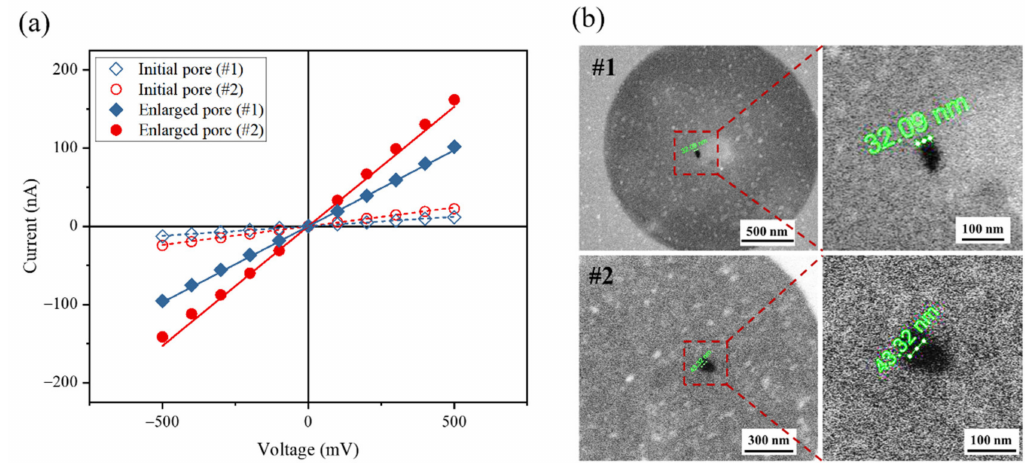
Figure 3. ( a ) I–V curves of nanopores before and after enlargement breakdown; ( b ) SEM images of nanopores after enlargement